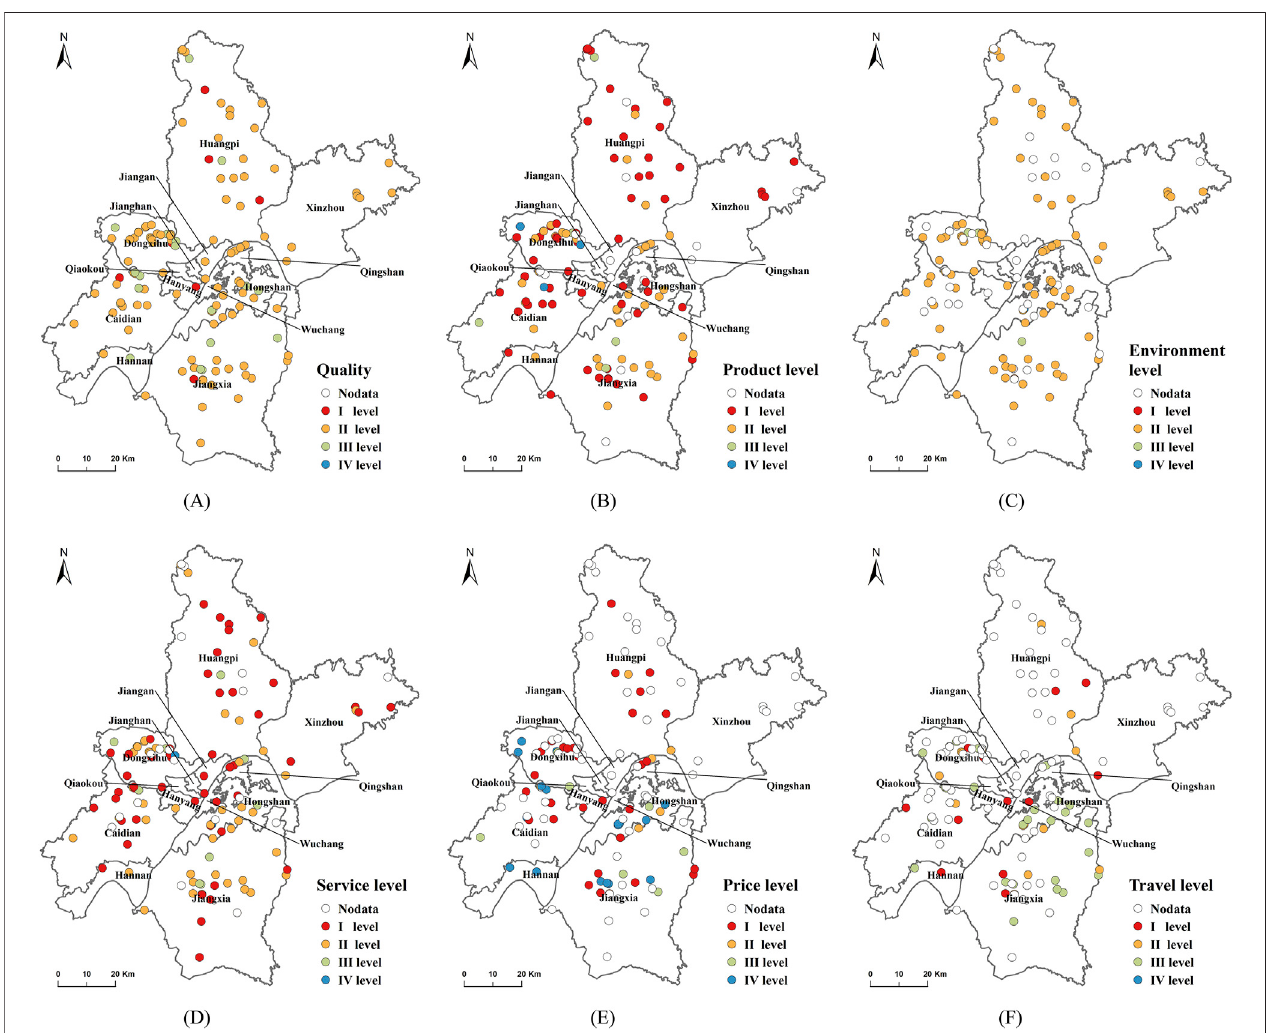
FIGURE7| Spatialdistribution ofthequality evaluation ofleisureagriculture inWuhan: (A) Overallquality; (B) Product level; (C) Environmentlevel; (D) Servicelevel; (E) Price level; (F) Travel level.